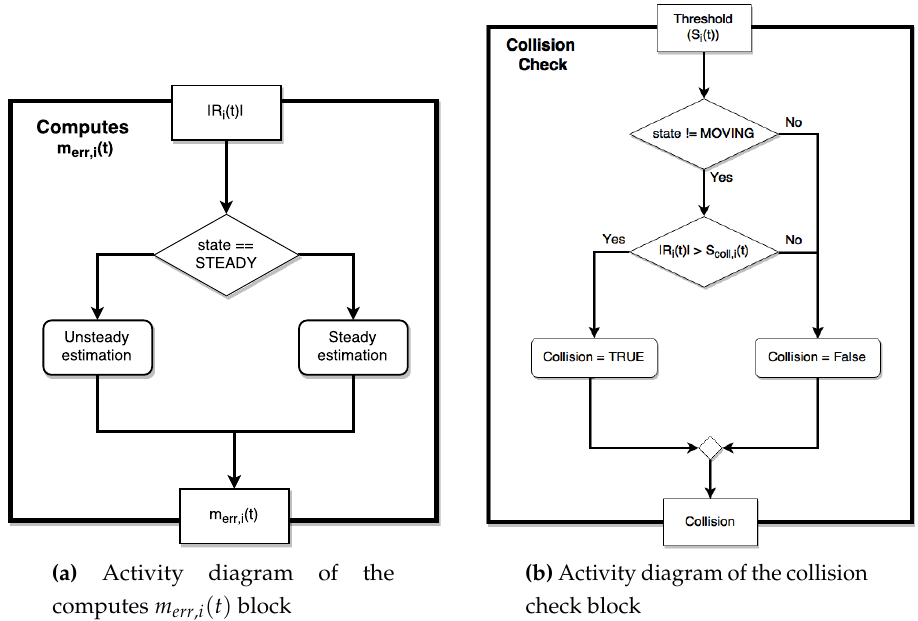
Figure 13. Activity diagrams of the blocks computing the terms of the threshold function.